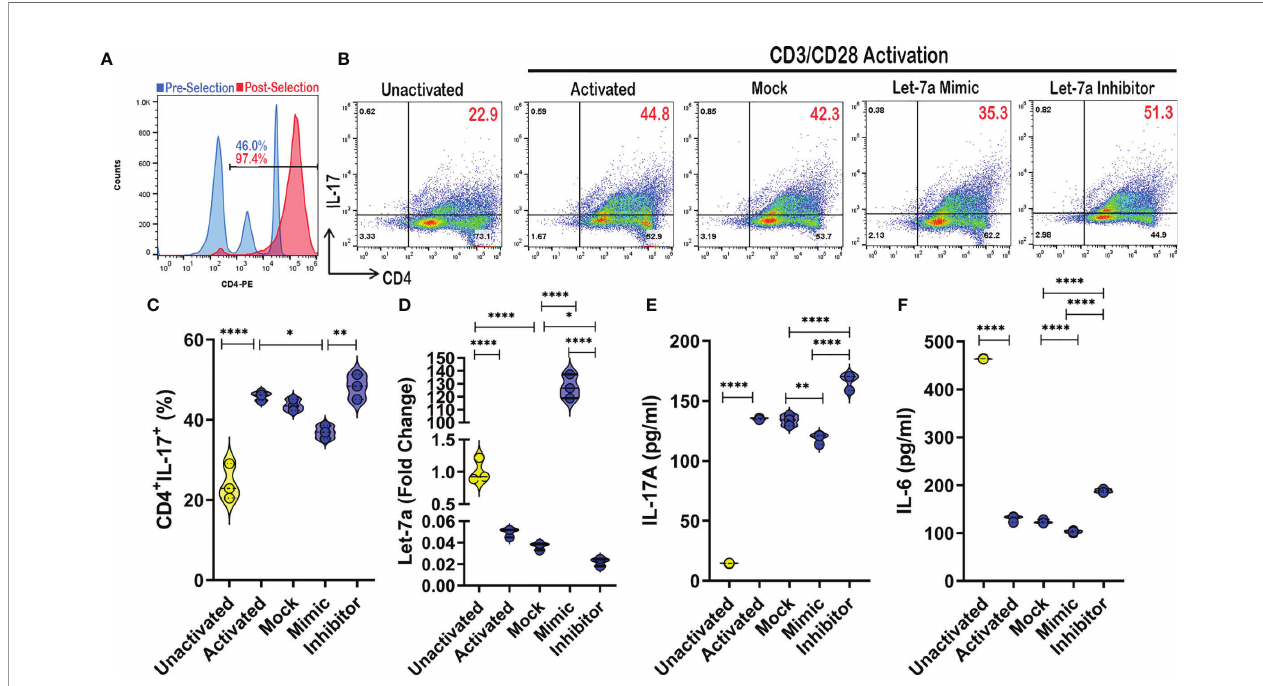
FIGURE 5 | Let-7a modulation affects Th17 development and function. (A) CD4+ cells were puri fi ed using magnetic bead separation from PBMCs provided by healthy control donor, which was validated using fl ow cytometry to ensure purity (>95%). (B) Representative fl ow cytometry plots depicting Th17 cells (CD4+IL-17A +) in unactivated or CD3/CD28 activation cultures (24 hours) in the absence or presence of mock, let-7a mimic, or let-7a inhibitor. Red numbers indicating double positive TH17 percentage. (C) Violin plot depicting Th17 percentages as assessed by fl ow cytometry. (D) Violin plot depicting expression of let-7a as assessed by PCR. (E) Violin plot depicting IL-17 concentration as assessed by ELISA from cell culture supernatants. (F) Violin plot depicting IL-6 concentration as assessed by ELISA from cell culture supernatants. In vitro data are representative of at least 3 independent experiments, with 3 samples per culture condition. One way ANOVA was used to determine signi fi cance between groups. Signi fi cance was determined as p-value ≤ 0.05(*), ≤ 0.01(**), ≤